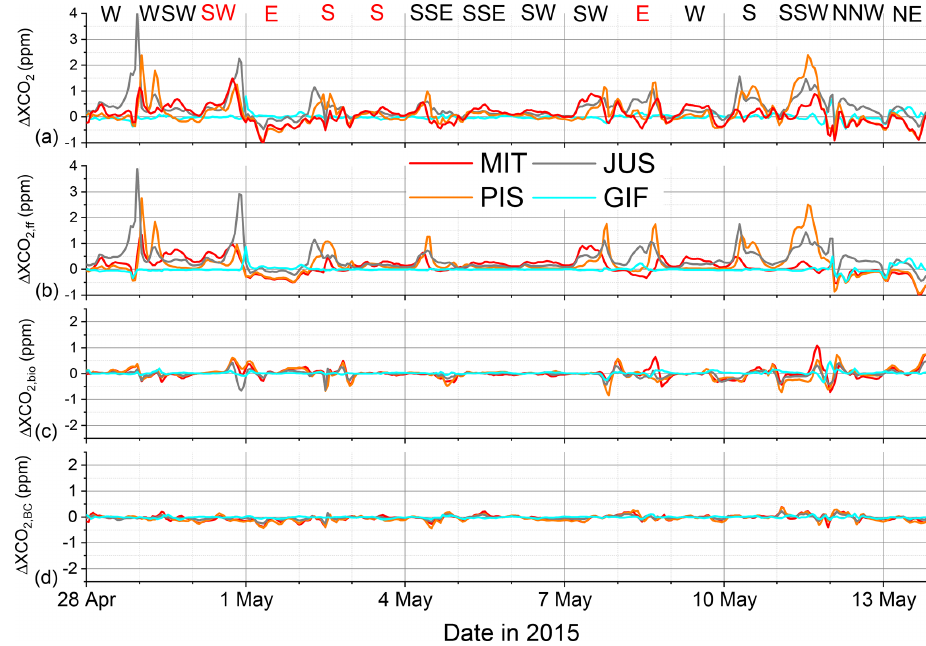
Figure 7. Modelled XCO 2 gradients for each station relative to RES are given in (a) with its contributing components in the panels below. Total (cid:49) XCO 2 (a) , the fossil fuel contribution to (cid:49) XCO 2 , ff (b) , the biogenic contribution to (cid:49) XCO 2 , bio (c) and the influence of the boundary conditions (cid:49) XCO 2 , BC (d) . The dominant wind conditions for each day given at the top of the figure and days without observations due to precipitation are in red.